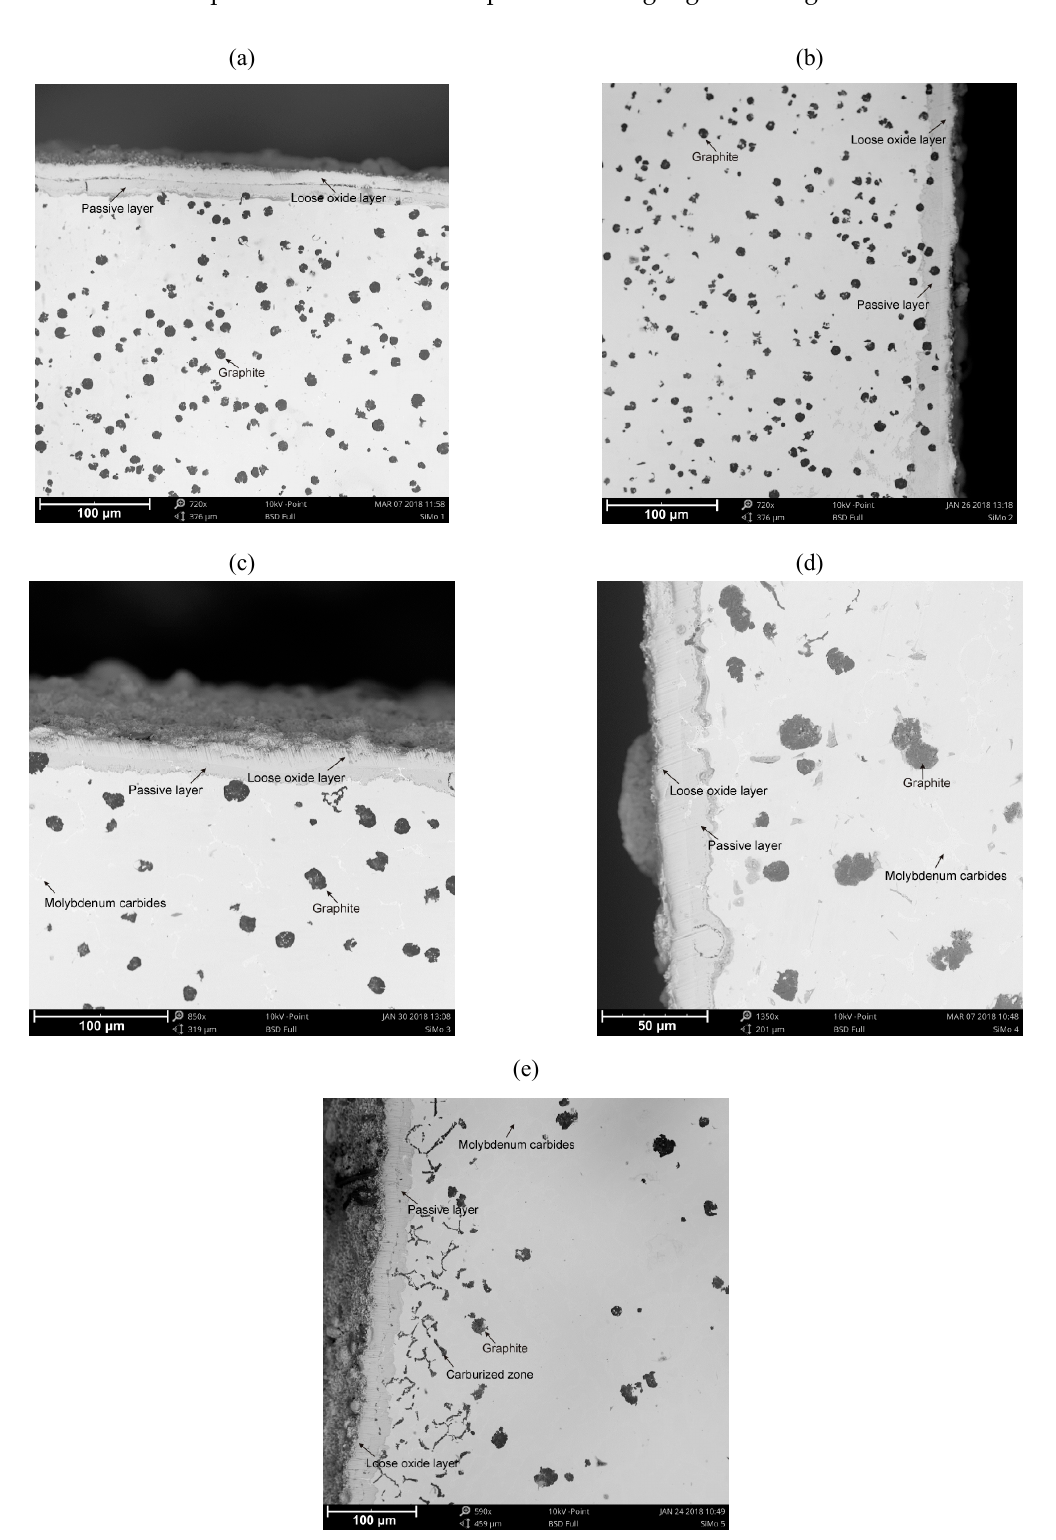
Figure 2. Microstructure of SiMo cast iron after the corrosion test cycle. SiMo cast iron with addition of: ( a ) 0.01% Mo, ( b ) 0.47% Mo, ( c ) 1.09% Mo, ( d ) 1.92% Mo, ( e ) 2.51% Mo. SEM. In all cases (SiMo samples 1–5), the thickness of passive layers is around 10 μ m. For elevated molybdenum content (Figure 2e, SiMo melt 5, 2.51% Mo) in the near-surface layer, the carburized